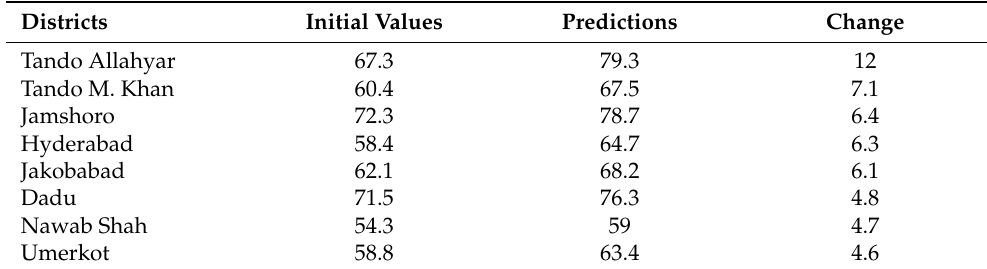
Figure 8. XGBoost predictions: ( a ) childhood stunting initial state; ( b ) result of 10 p.p. increase in MPI; ( c ) result of 10 p.p. increase in climate vulnerability. Table 3. Predictions and observed changes in case of the first scenario—10% growth in multi- dimensional poverty (most affected